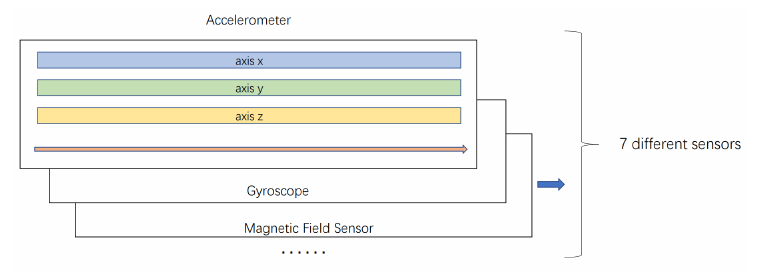
Figure 8. The data